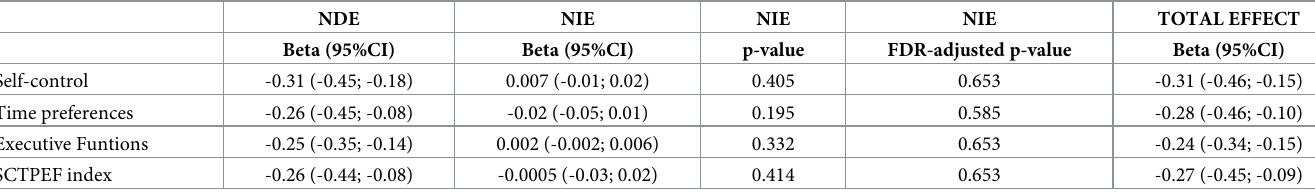
Table 2. Total, natural direct (NDE) and indirect effect (NIE) of the STYL experiment on antisocial behavior using intention to treat (ITT) Z-score estimates. NDE NIE NIE NIE TOTAL EFFECT Beta (95%CI) Beta (95%CI)